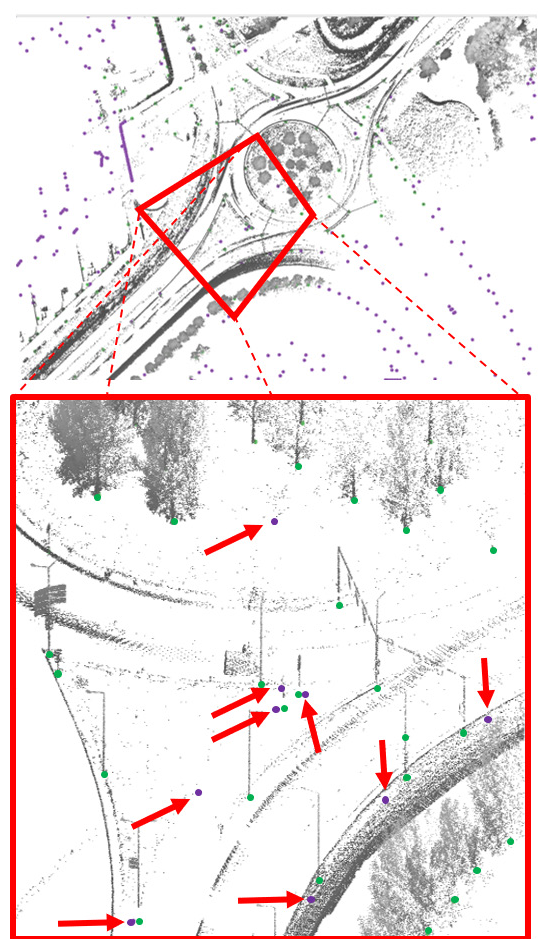
Figure 10. Detected mismatches between MLS data and map points in purple (highlighted by the red arrows. Green dots are the successful matches between map point and MLS segment.